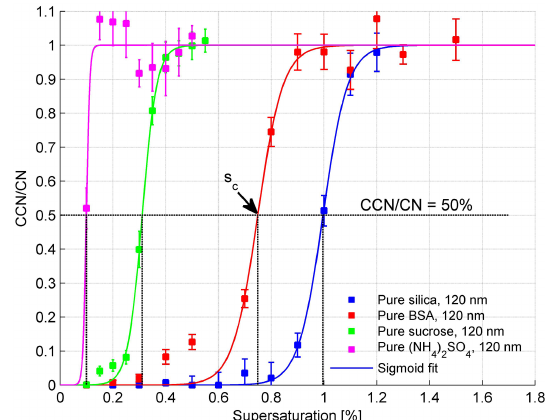
Figure 4. The average activation ratio of pure soluble or insoluble particles with the mobility diameter of 120nm at different super- saturations. Error bars represent the standard deviation of the acti- vation efficiency of about 20 measurements corresponding to each supersaturation of the instrument. Critical supersaturation s c is de- fined as the point where the activation ratio is equal to 50%.